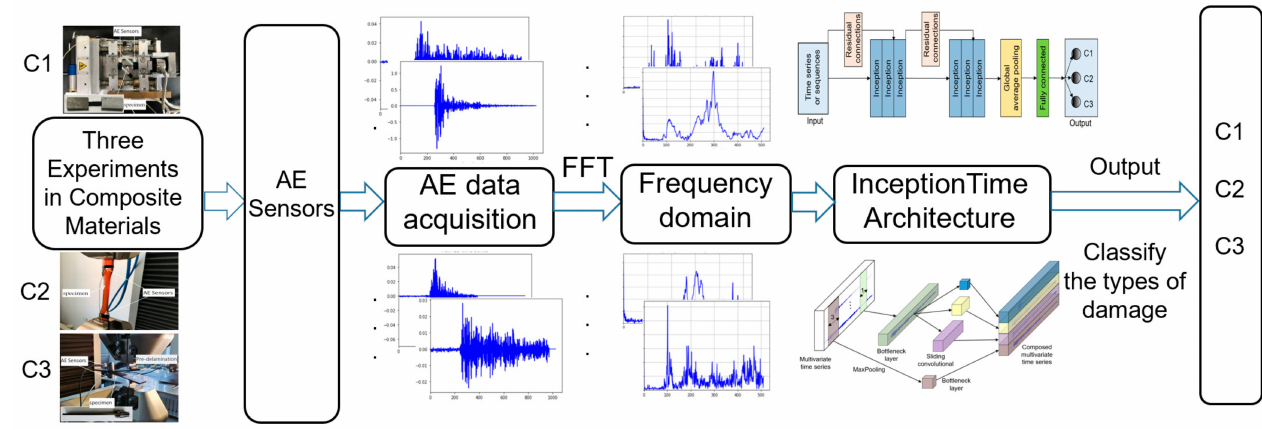
Figure 7. Schema of InceptionTime deep learning model based on frequency-domain sequences for the damage classification of composite